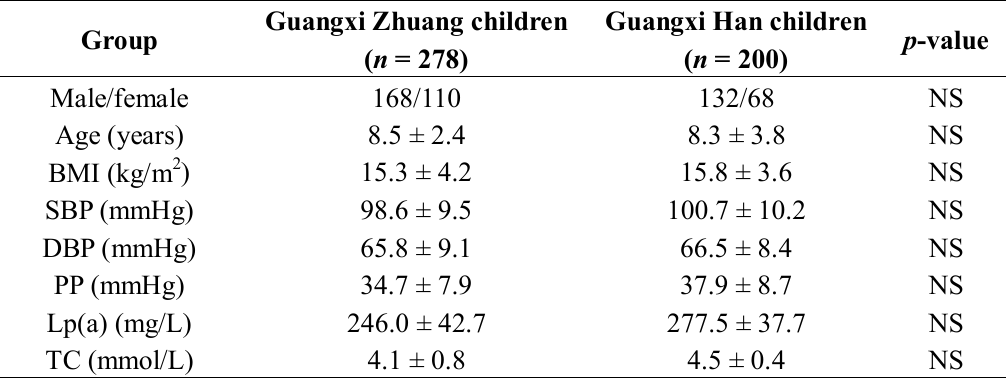
Table 1. The general characteristics and serum lipids of the Guangxi Zhuang and Han children.